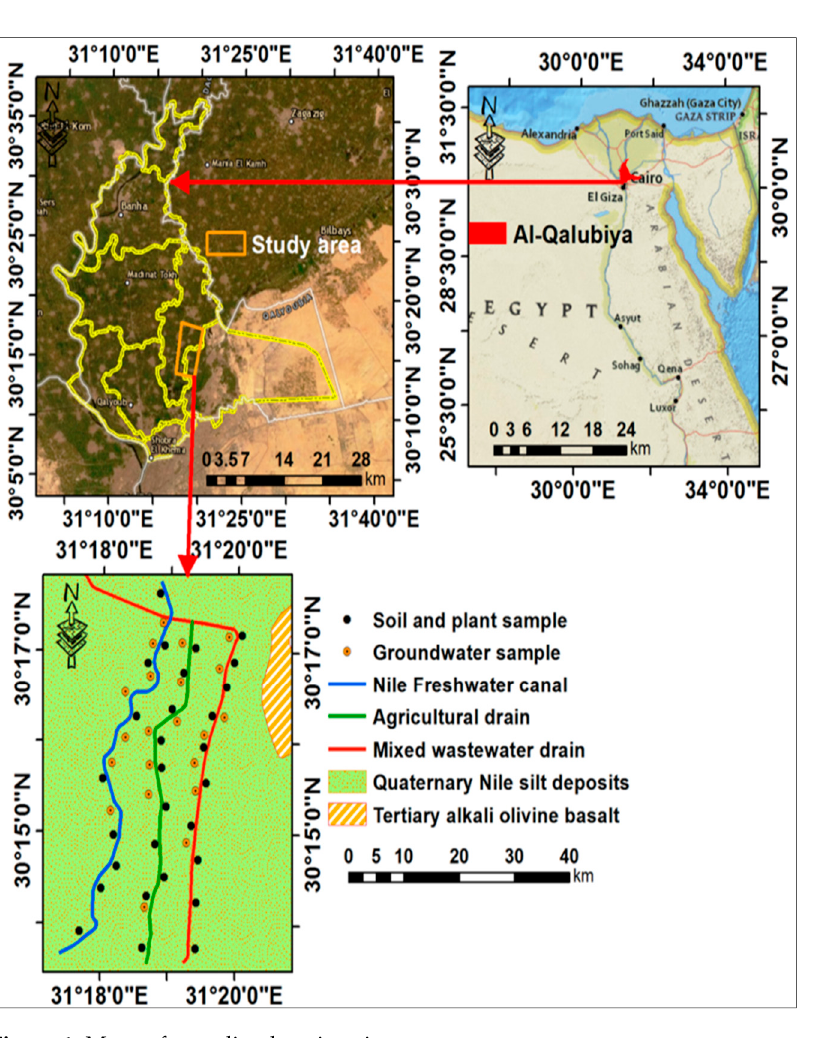
Figure 1. Maps of sampling location sites.